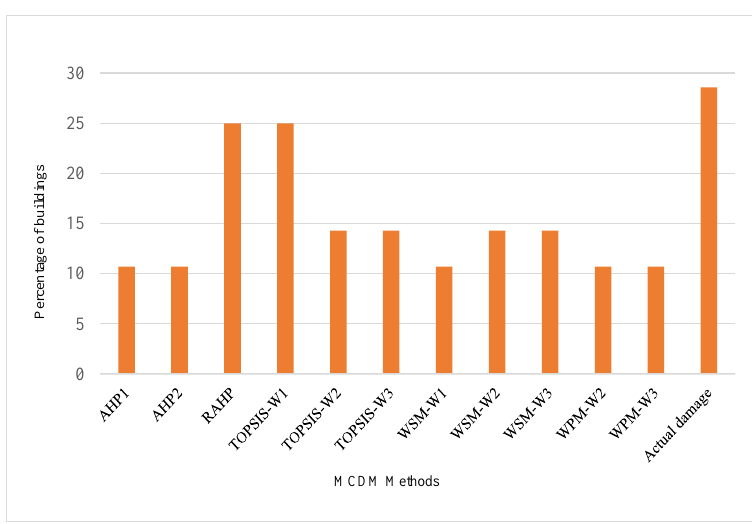
Figure 5. Percentage of buildings belongs to damage state 1 from MCDM